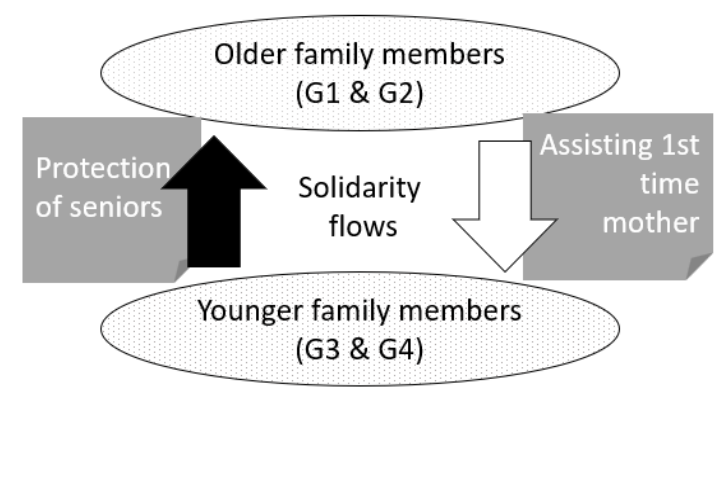
Figure 1 : Two directions of solidarity flows during the